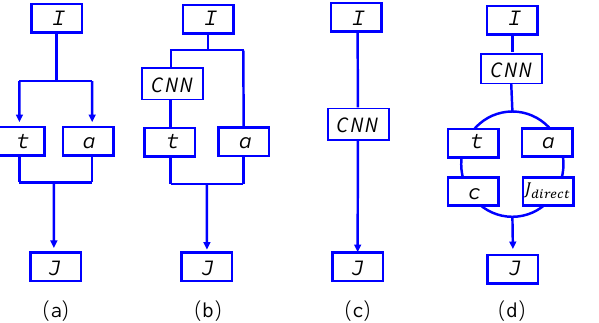
Figure 1. Different diagrams of dehazing schemes: ( a ) traditional two-step dehazing strategy; ( b ) estimate the transmission matrix through CNN; ( c ) end-to-end diagrams; ( d ) the proposed diagrams that estimates the transmission t , atmospheric light a , aerosol color c , and preliminary enhancement results J direct